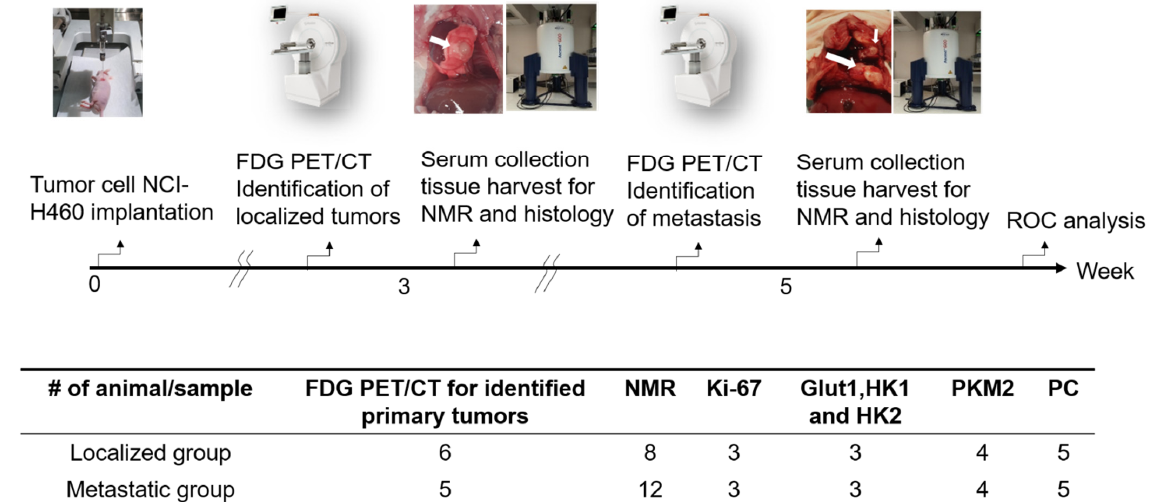
Figure 2. Flow chart of animal experiments. The number of animals used in each experiment are displayed. Mice were identified localized tumors and metastatic tumors by FDG PET/CT followed by the serum metabolites of the NMR studies and tissue Western blotting. The validations of localized and metastatic tumors were by histology.